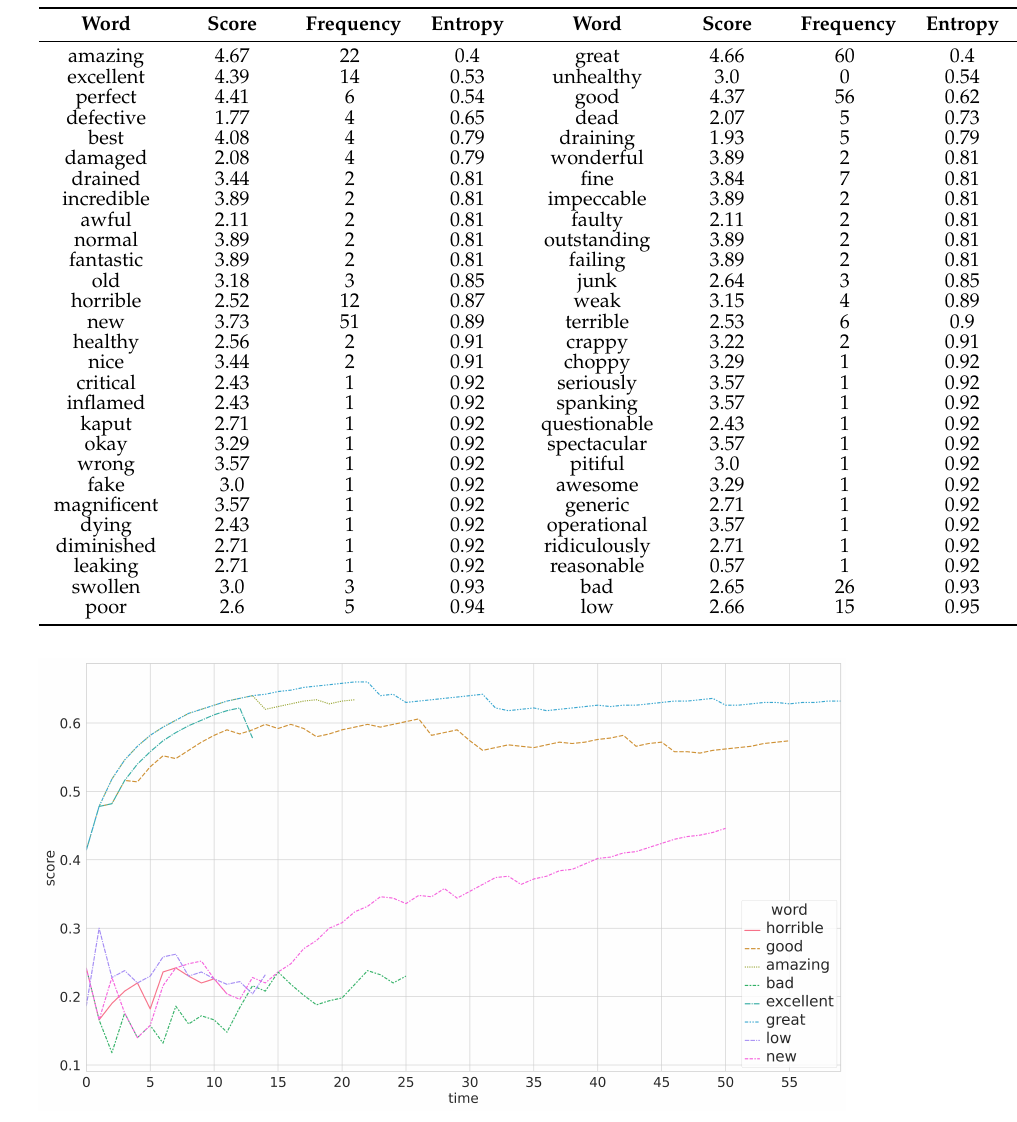
Figure 5. Sentiment score over time of battery-descriptive